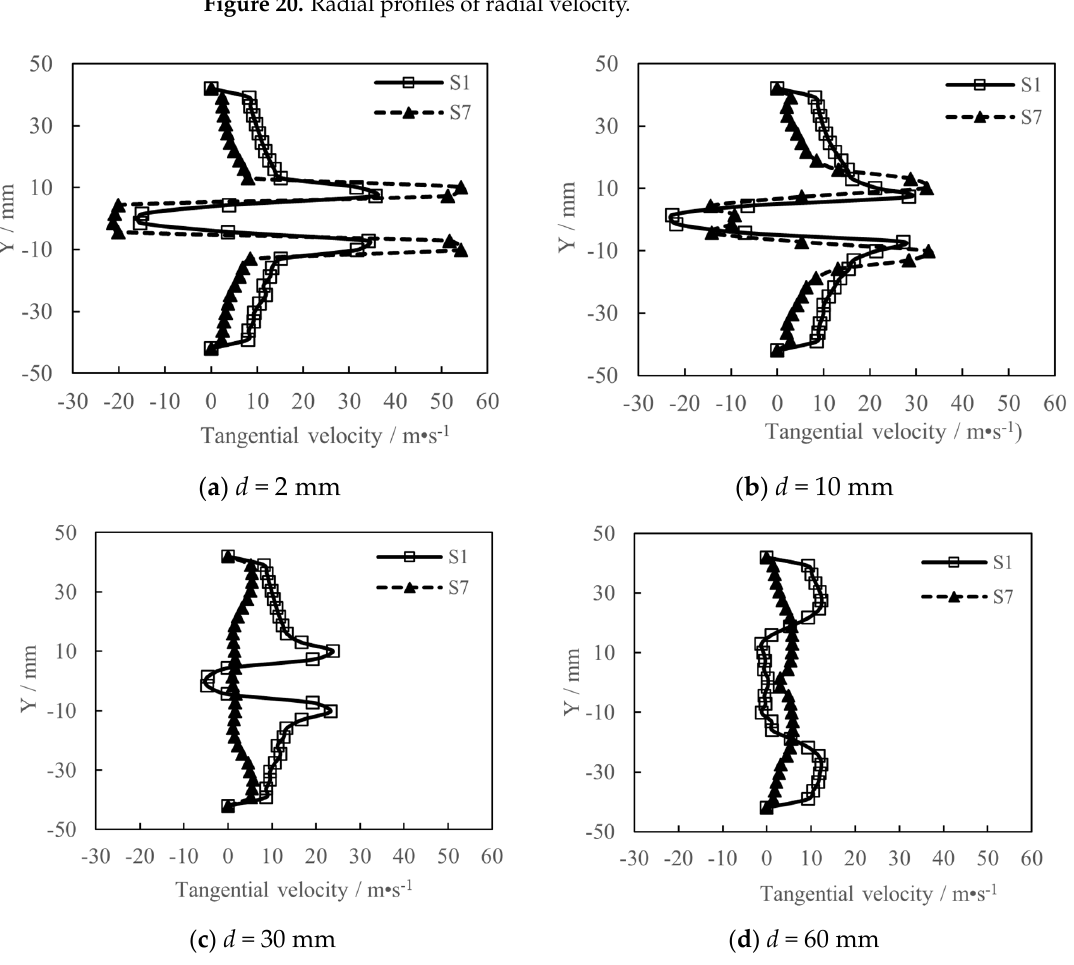
Figure 21. Radial profiles of tangential velocity.